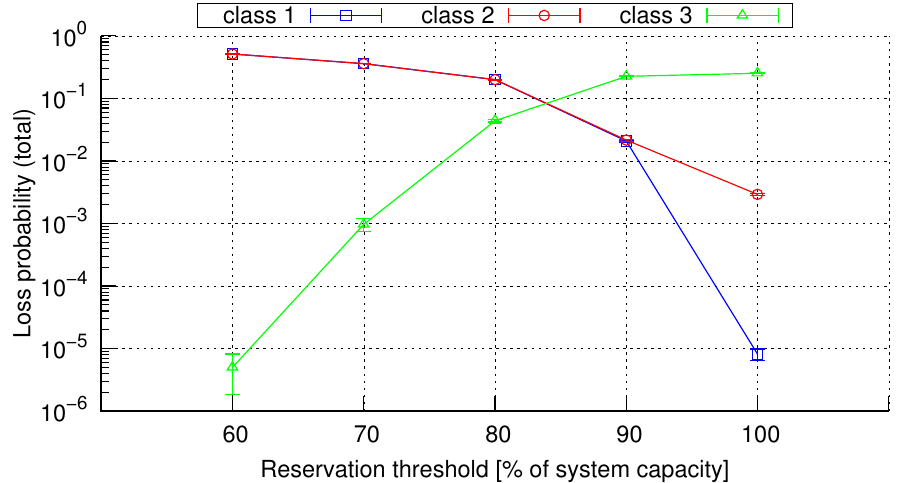
Figure 16. Changes in the loss probability for calls of individual traffic classes in System 1 in relation to the value of reservation threshold. The results are presented for the value a = 0.9 Erl of traffic offered to a single